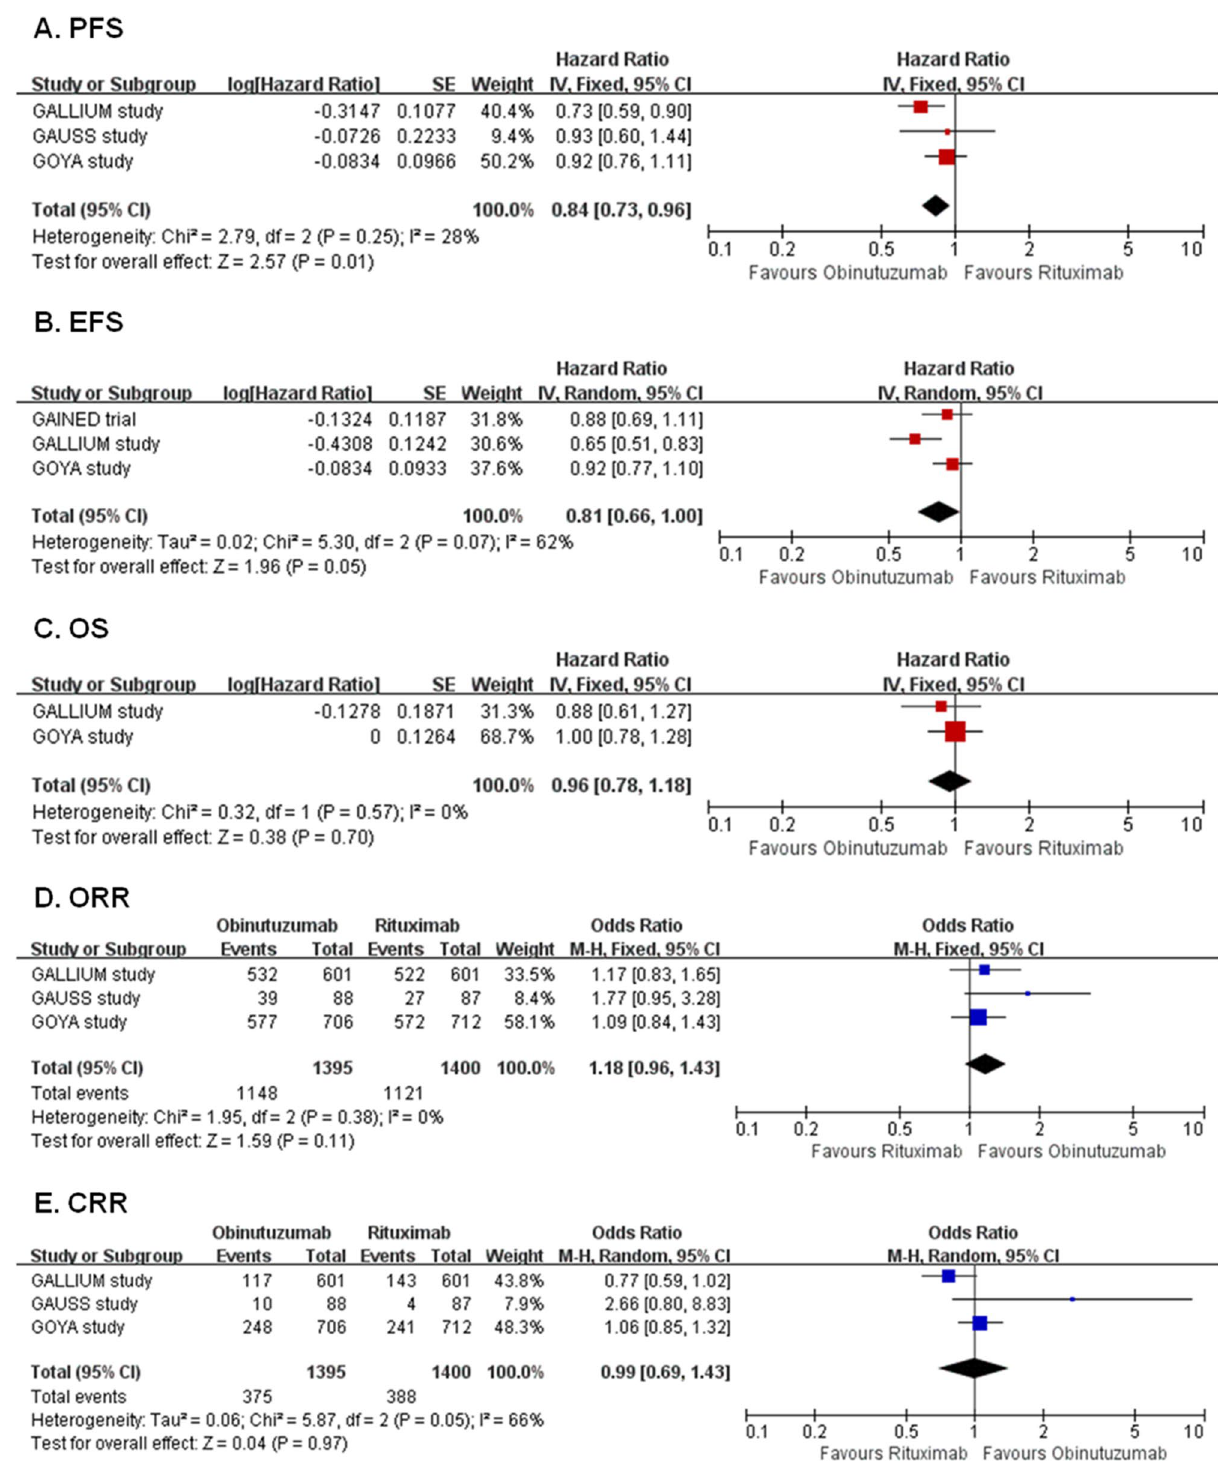
Figure 2. Forest plots of obinutuzumab versus rituximab. Forest plot of the meta-analysis that estimating the ORs and HRs with their corresponding 95% CIs for the obinutuzumab group, compared with that in the rituximab group. PFS progression-free survival, EFS event-free survival, OS overall survival, ORR overall response rate, CRR complete response rate, HRs hazard ratios, ORs odds ratios, 95% CI 95% confidence